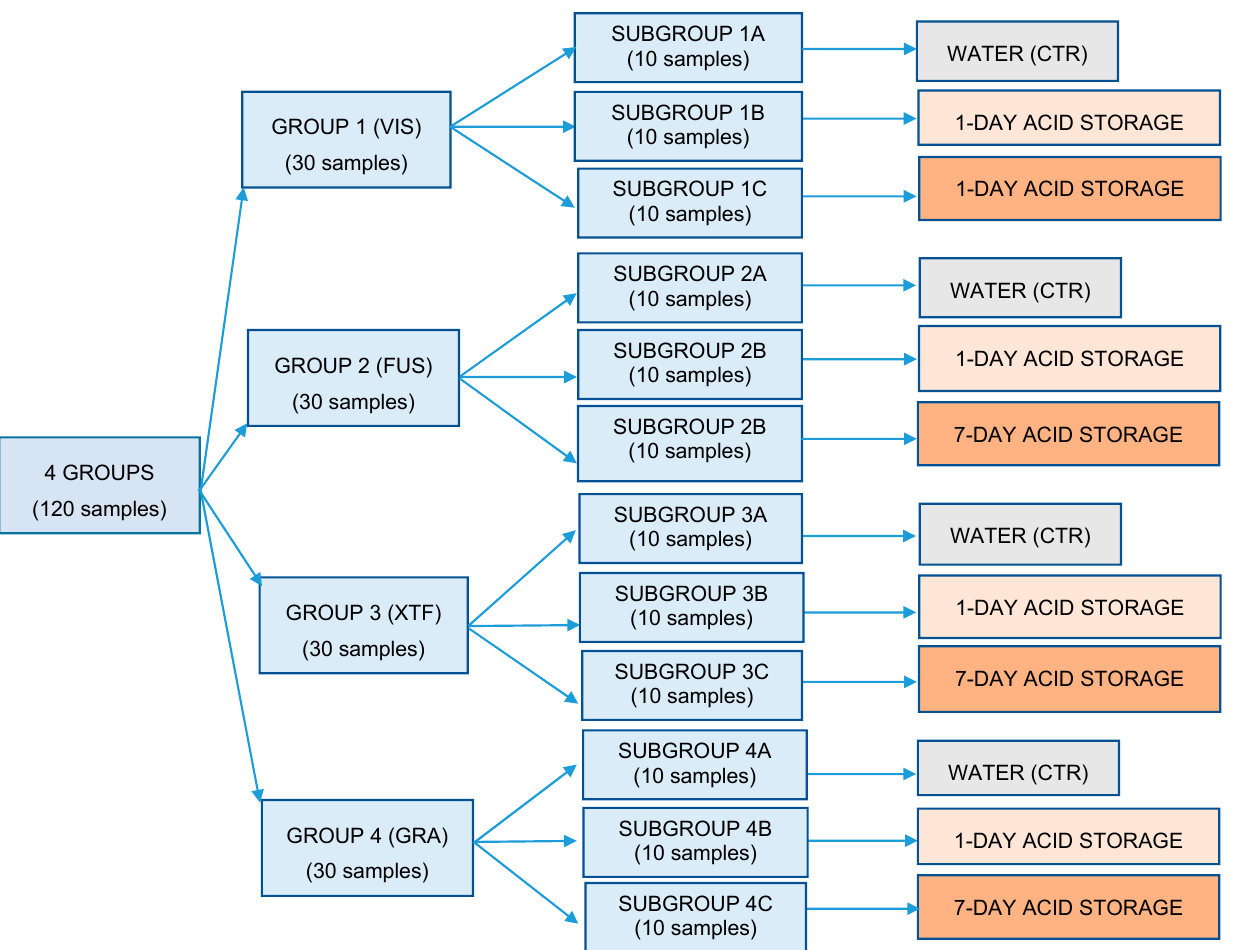
Figure 1. Flow chart showing how samples were divided into groups and subgroups and the respective treatment assigned. CTR: subgroup of control.